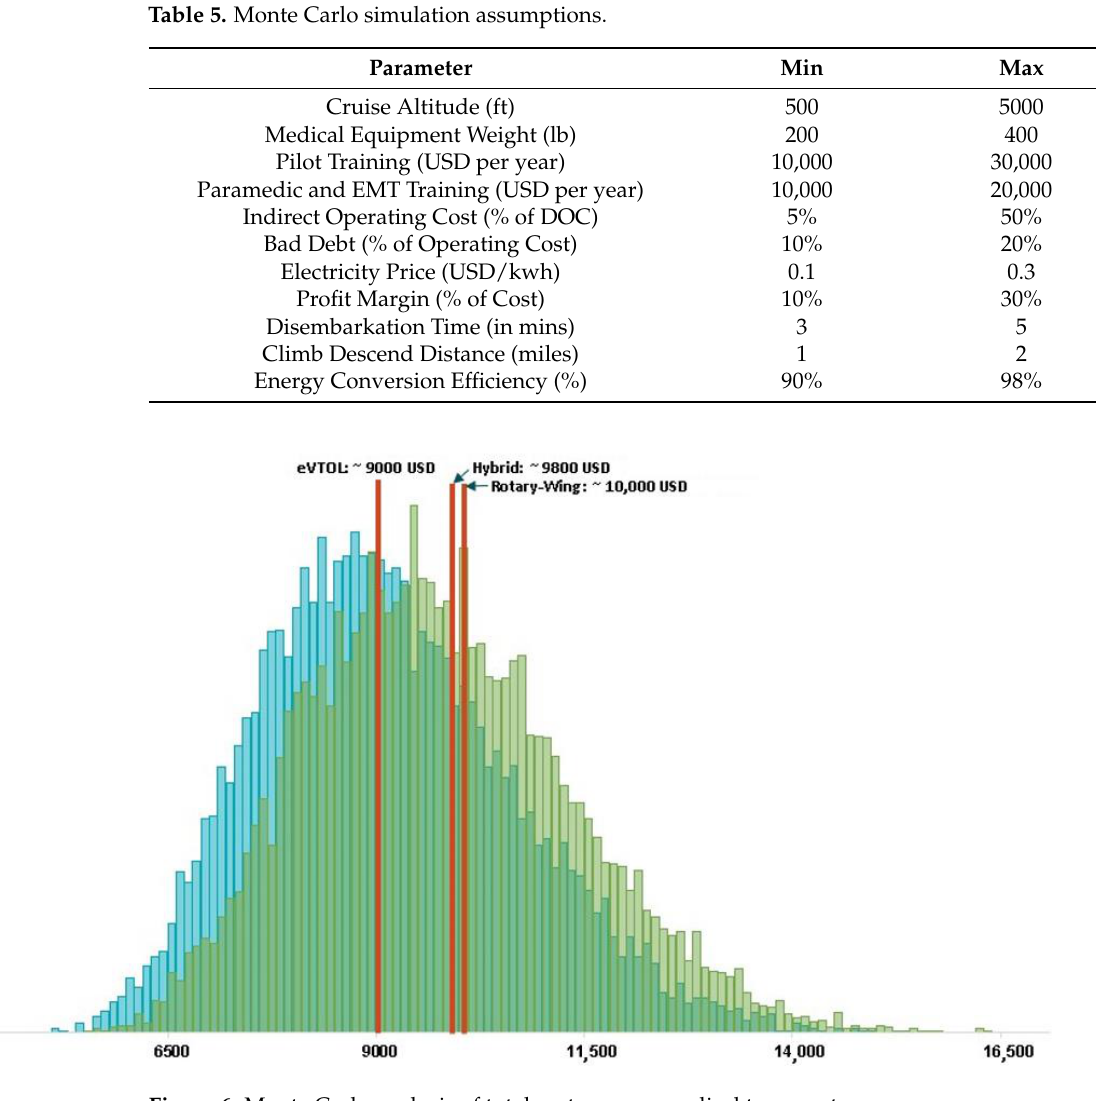
Figure 6. Monte Carlo analysis of total cost per aeromedical transport.